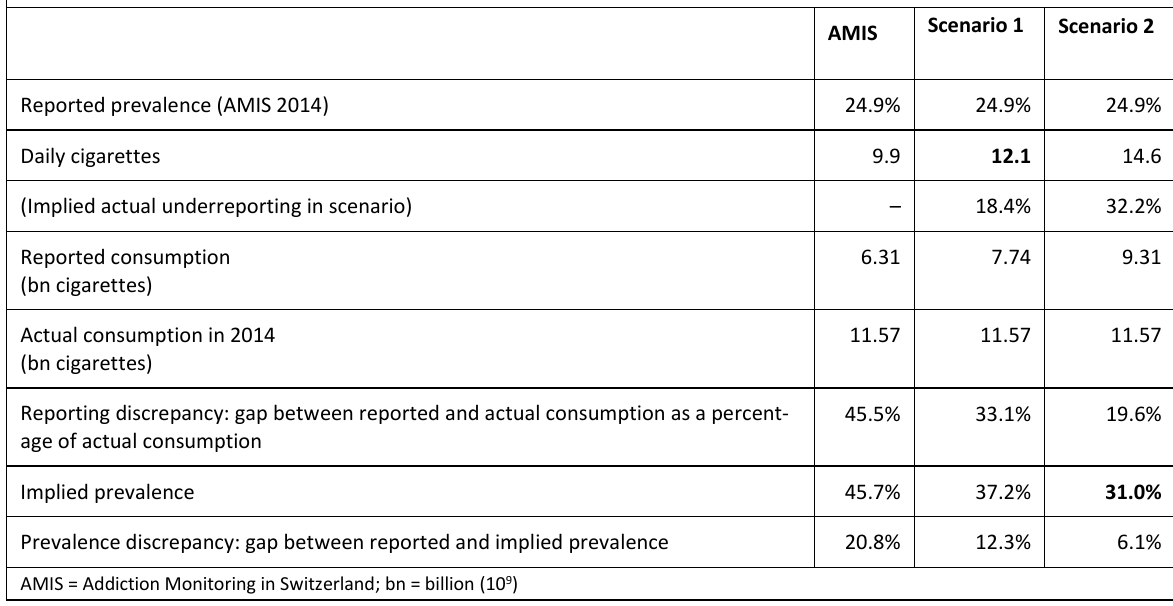
Table 5: Two scenarios of smoking intensity in Switzerland. Scenario 1: Daily cigarettes same as maximum for France after correction for underreporting; Scenario 2: Prevalence of smoking same as France. The fixed variable for each scenario is shown in bold type.